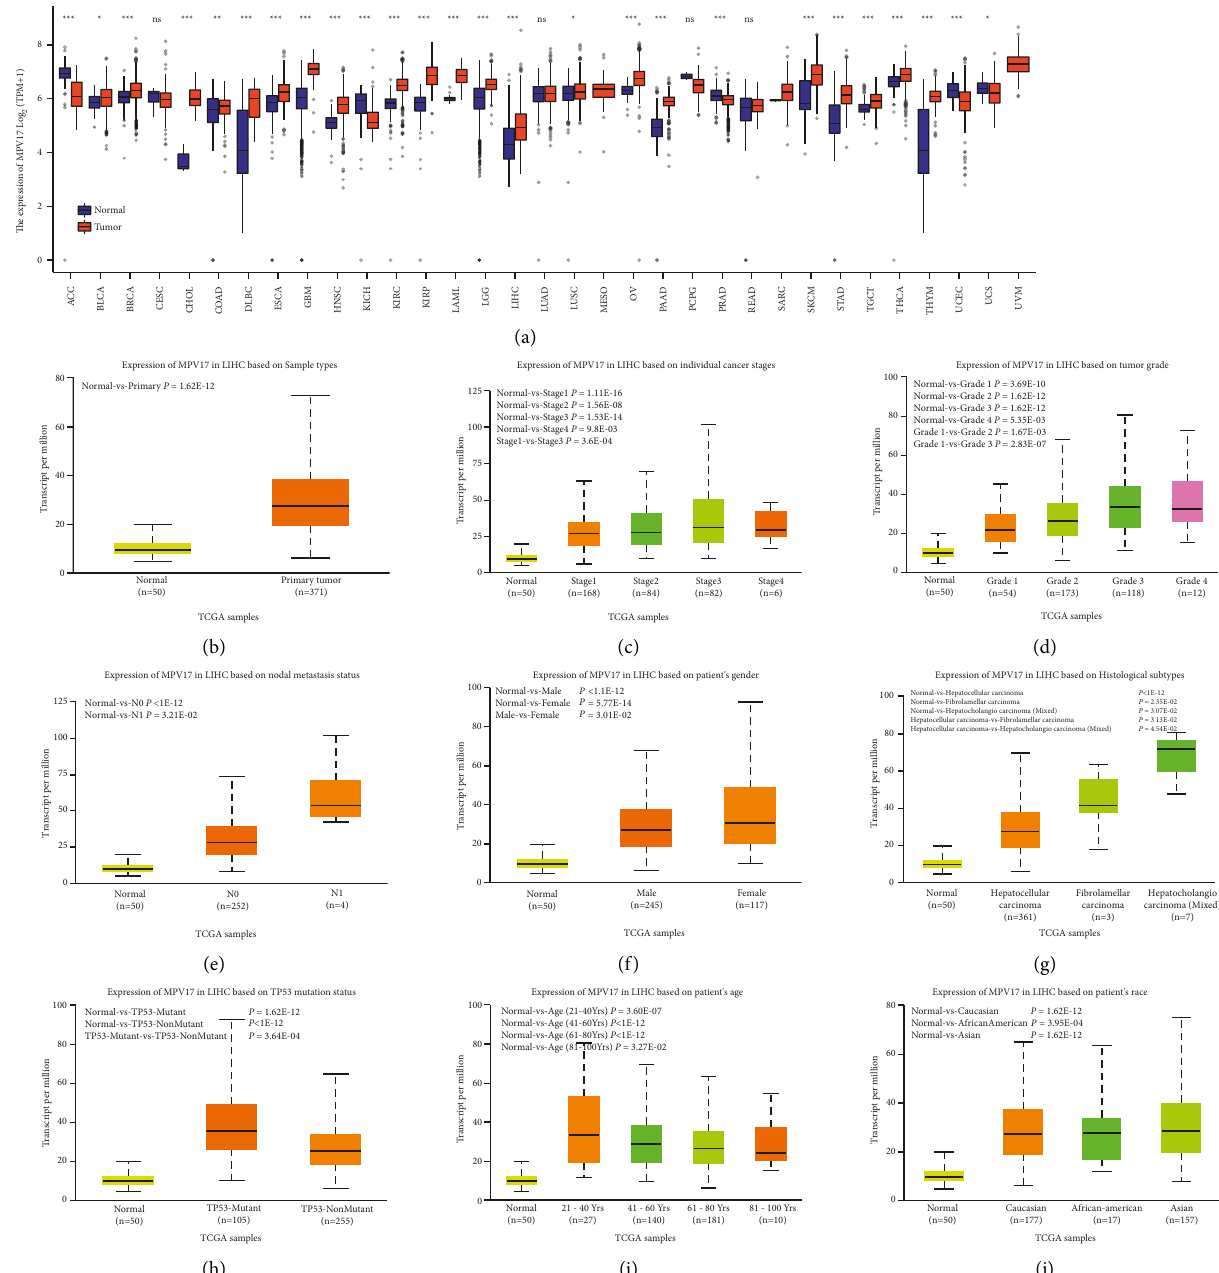
Figure 1: Relationship between MPV17 expression patterns and clinicopathological features in LIHC patients. (a) MPV17 expressions in pan-cancers and corresponding normal samples. (b) Comparison of MPV17 expression in primary LIHC tissues ( n � 371) and normal tissues ( n � 50). (c–j) MPV17 expression levels correlated with the individualized cancer stage (c), tumor grade (d), lymph node metastasis status (e), gender (f), histological subtype (g), TP53 mutation status (h), age (i), and race (j) of LIHC patients. ∗ P < 0 . 05; ∗∗ P < 0 . 01; ∗∗∗ P < 0 .